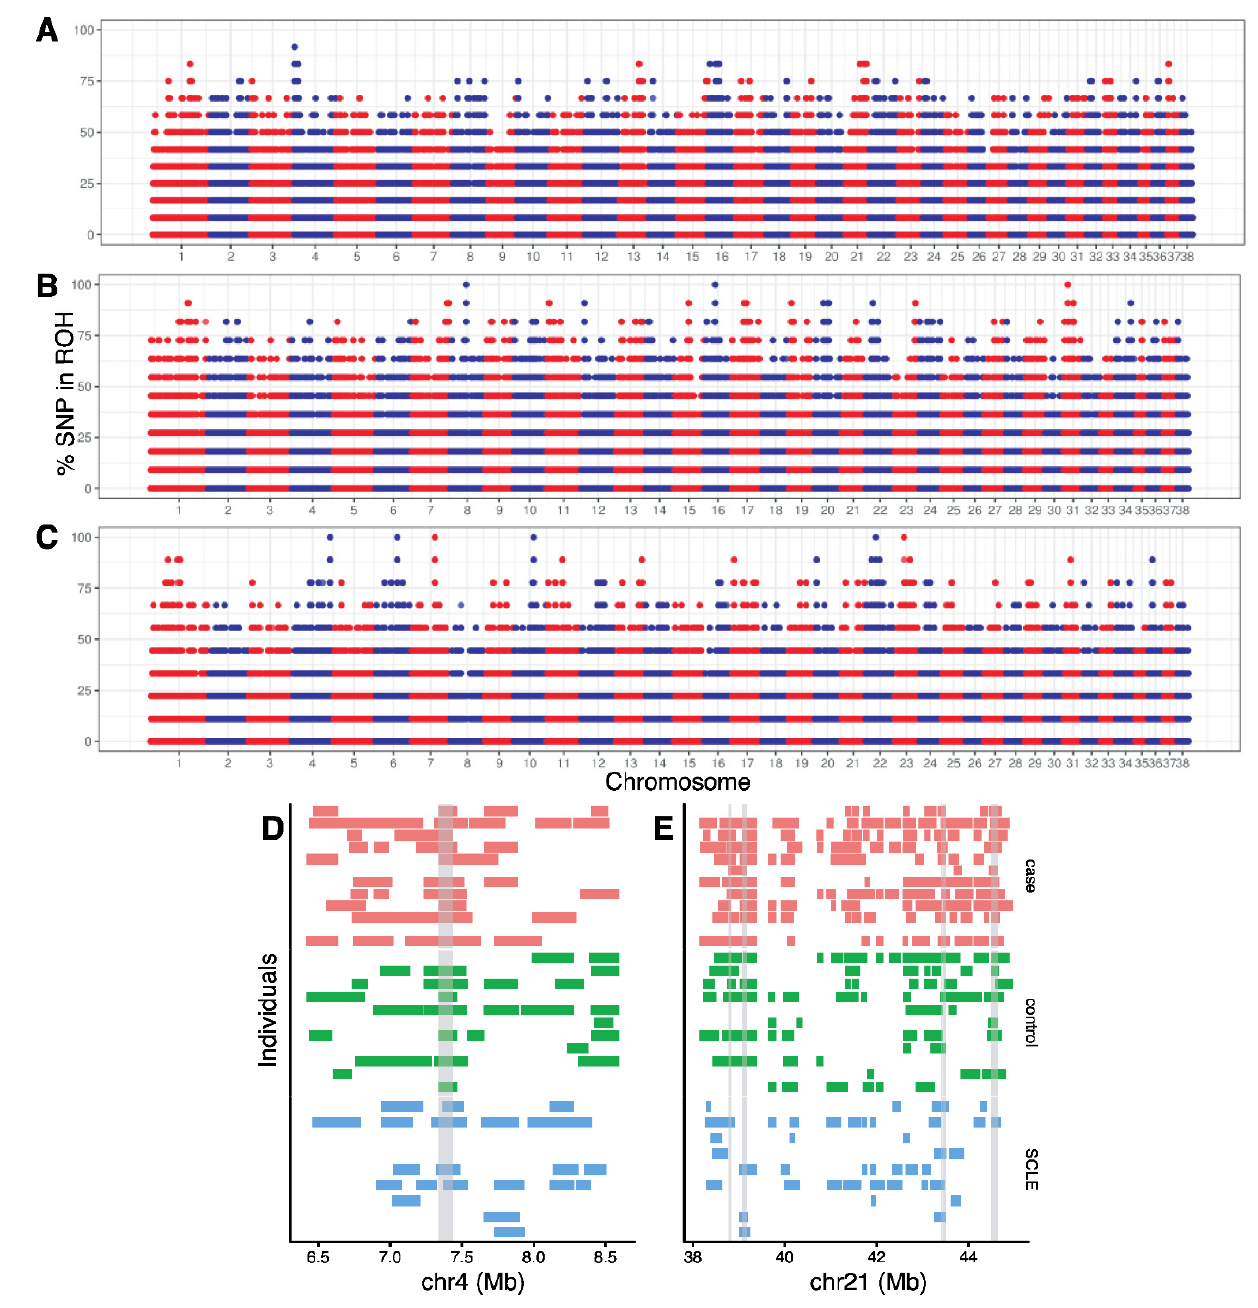
Figure 4. Manhattan plot of the proportion of times each SNV falls within a ROH in the ( A ) cases, ( B ) SCA controls and ( C ) SCLE controls. Chromosomes 1–38 are arranged left to right, with alter- nating red and blue representing different chromosomes. ( D ) ROH detected in each individual on a part of chromosome 4 and ( E ) chromosome 21. Gray bars represent regions where 75% of cases (shown in salmon) have overlapping ROH and less than 75% of SCA controls (shown in green) and SCLE controls (shown in light blue). See supplemental information for genome-wide ROH for each individual.